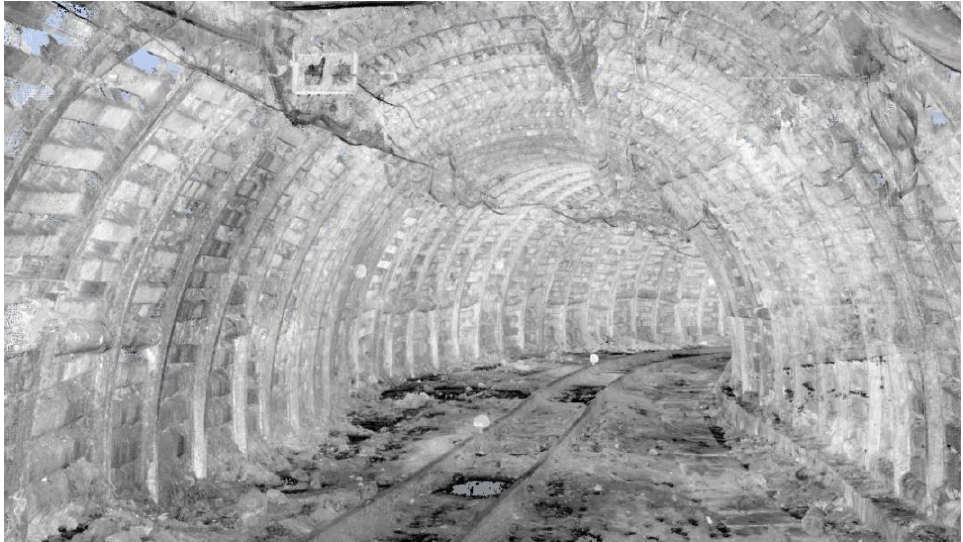
Figure 3. Point cloud view of the mine tunnel straight section near the